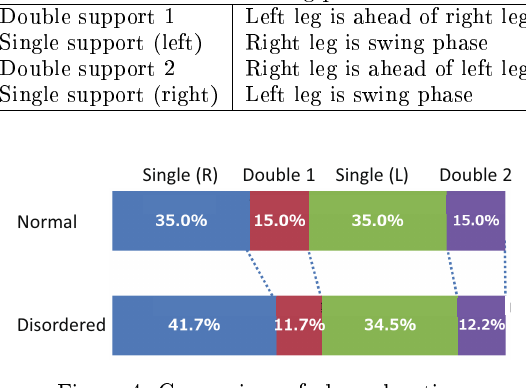
Figure 4: Comparison of phase